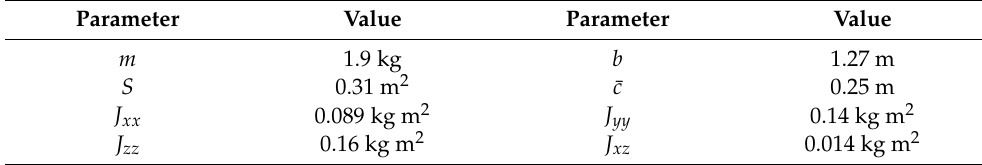
Table 1. Characteristics for US 34e.